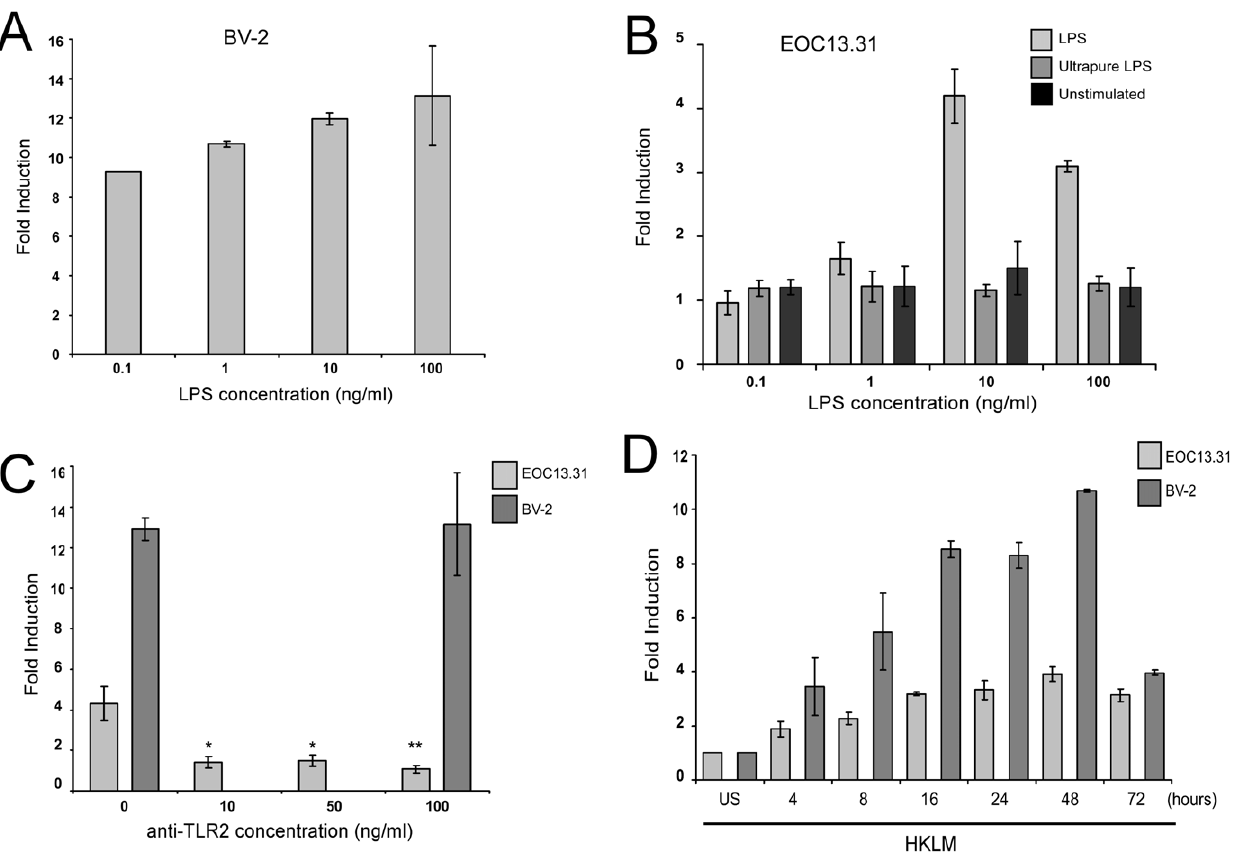
Figure 2. MiR-146a induction in microglia. A. LPS at concentrations ranging from 0.1–100 ng/ml was used to stimulate BV-2 cells. After 8 hours, RNA was collected and TaqMan H qRT-PCR was used to determine miR-146a expression relative to PBS treated (unstimulated) control cells. The experiment was performed in triplicate and the average fold induction is shown. B. EOC 13.31 cells were stimulated with 100 ng/ml semi-pure LPS, 100 ng ultra-pure LPS or PBS alone (unstimulated). RNA was collected after 8 hours and miR-146a expression was measured by TaqMan H qRT-PCR. Fold induction relative to untreated cells is shown. The experiment was performed in triplicate and the average fold change is shown. C. EOC 13.31 cells were incubated with increasing concentrations of an anti-TLR2 antibody for 30 minutes prior to stimulation with 100 ng/ml LPS. MiR-146a expression relative to mock-treated control cells was measured by TaqMan H qRT-PCR. Inhibition of miR-146a expression following anti-TLR2 antibody treatment was significant at all concentrations; 10 and 50 ng/ml * p , 0.01, 100 ng/ml ** p , 0.005. Treatment of BV-2 cells with 100 ng/ml anti-TLR-2 antibody prior to LPS stimulation failed to inhibit miR-146a induction. The experiment was performed in triplicate and the average fold change is shown. D. EOC 13.31 and BV-2 cells were stimulated with with 10 8 heat-killed Listeria monocytogenes (HKLM) cells/ml. RNA was collected at various time-points over 72 hours and miR-146a expression measured by TaqMan H qRT-PCR. Fold induction relative to unstimulated cells (US) is shown. The experiment was performed in triplicate and the average fold change is